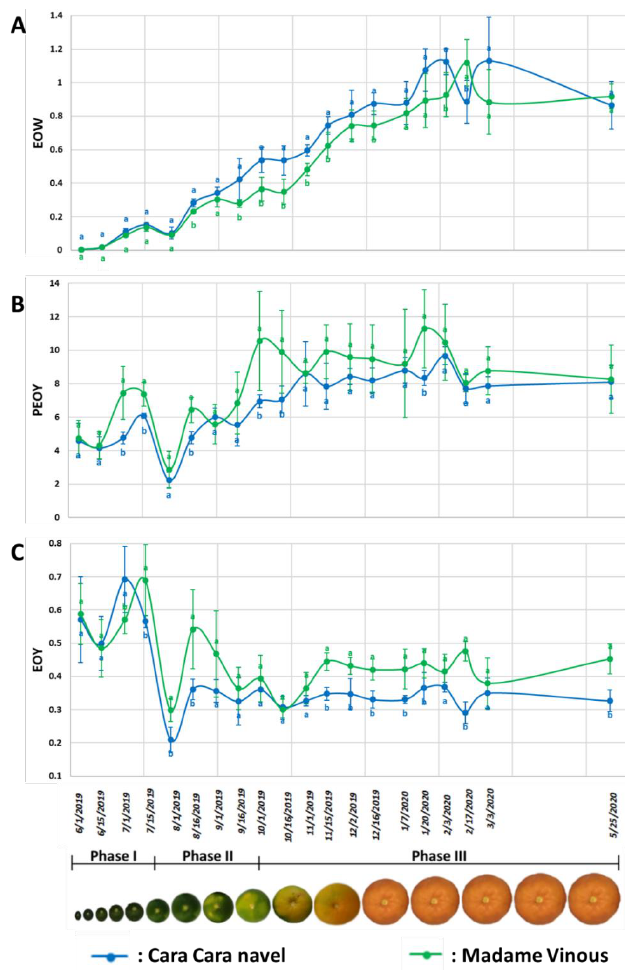
Figure 2. Dot plots representing the evolution of the average weight (g) of essential oil per fruit ( A ), the average weight (g) of essential oil per 100 g of dried peel ( B ) and the average weight (g) of essential oil per 100 g of fresh fruit ( C ) throughout fruit development. The vertical bar represents the standard deviation , and the letter in each plot represents the statistical group according to Tukey’s test ( p ≤ 0.05) of differences between cultivars at each date.